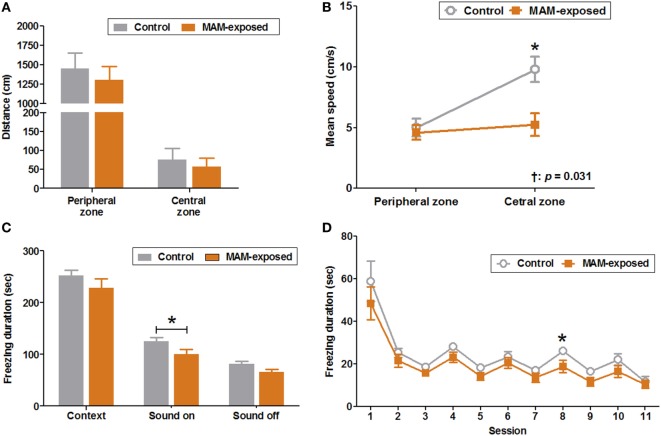
Behavioral abnormalities in prenatally methylazoxymethanol acetate (MAM)-exposed young rats. The open field test was performed at postnatal day (P) 30 and fear conditioning tests at P35–37. (A) The mean distances traveled in the peripheral and central zones did not differ between the groups. (B) Compared to controls (n = 16), MAM-exposed rats (n = 14) showed significantly slower mean speed in the central zone (9.8 ± 1.1 vs. 5.2 ± 0.9 cm/s, p = 0.016). The change in mean speed between peripheral and central zones differed significantly by group (p = 0.031). (C) The freezing response to context at P36 did not differ significantly between the groups. At P37, MAM-exposed rats showed significantly shorter freezing responses to conditioned sound stimuli (freezing duration with sound ON) (n = 16, 100.5 ± 9.6 s) than controls (n = 12, 124.8 ± 7.7 s, p = 0.047). (D) The freezing duration for each session in MAM-exposed rats and controls. The freezing duration on session 8 with a sound cue was significantly shorter for MAM-exposed rats (18.8 ± 3.0 s) than for controls (26.0 ± 1.2 s, p = 0.042). Values expressed as mean ± SEM. *p < 0.05 using the Mann–Whitney U test for comparison between the groups. †p < 0.05 using the Mann–Whitney U test for comparison of speed between peripheral and central zones by group.